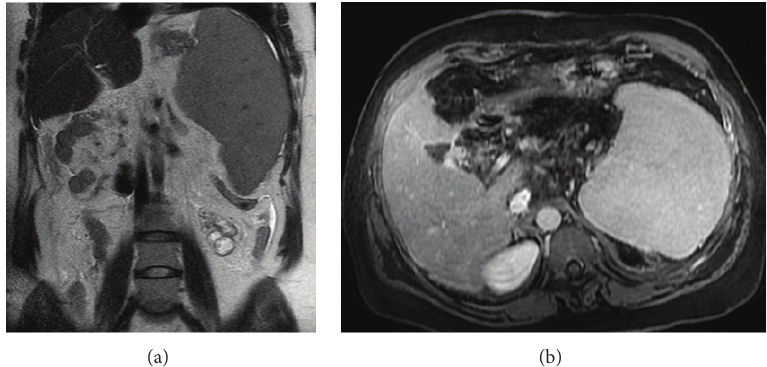
Figure 19: Splenomegaly. Coronal T2wi SSFSE (a) and postcontrast axial T1wi 3D-GRE with fat suppression in the interstitial phase (b). A homogeneous splenomegaly resulting from congestion (portal hypertension) is easily seen.